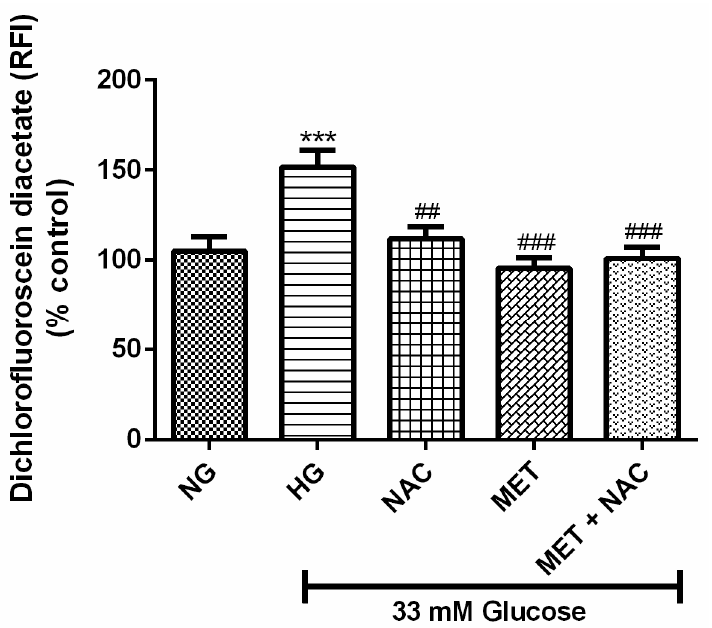
Figure 4. The combination effect of Metformin (MET) and N-acetylcysteine (NAC) on high glucose-induced oxidative stress. 2’, 7’-Dichlorofluorescin diacetate (DCFH-DA) fluorescence as a measurement of reactive oxygen species production was assessed in H9c2 cardiomyoblasts cultured in high glucose (HG; 33 mM) for 24 h. Cells co-treated with NAC (1 mM), metformin (MET) (1 µM) and a combination of MET+NAC attenuated this effect. Cells treated with normal glucose (NG) served as the vehicle control. Data are expressed as the mean ± SEM of 3 independent experiments with each experiment having 3 technical repeats ( n = 9). Significance is depicted as *** p ≤ 0.001 versus NG control, ## p ≤ 0.01, ### p ≤ 0.001 versus HG control.